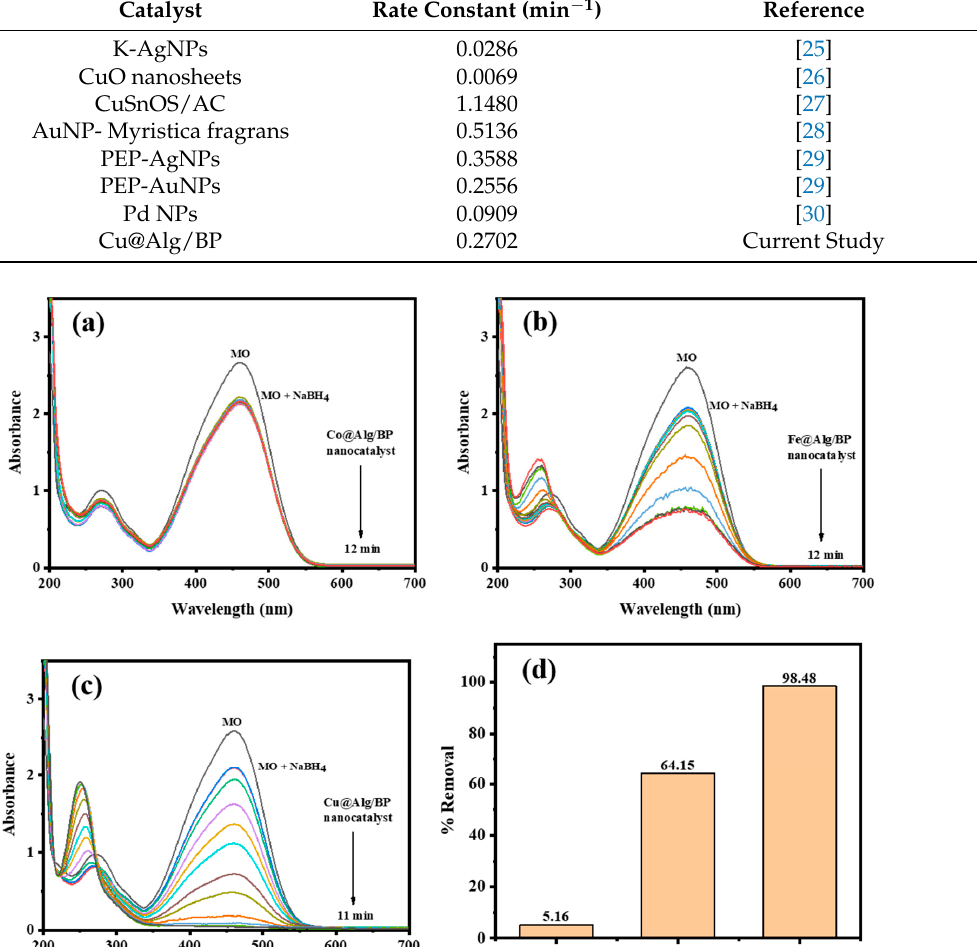
Table 1. Comparison of rate constant values of MO reduction reactions measured for different catalysts, reported in the literature, in presence of NaBH 4 .